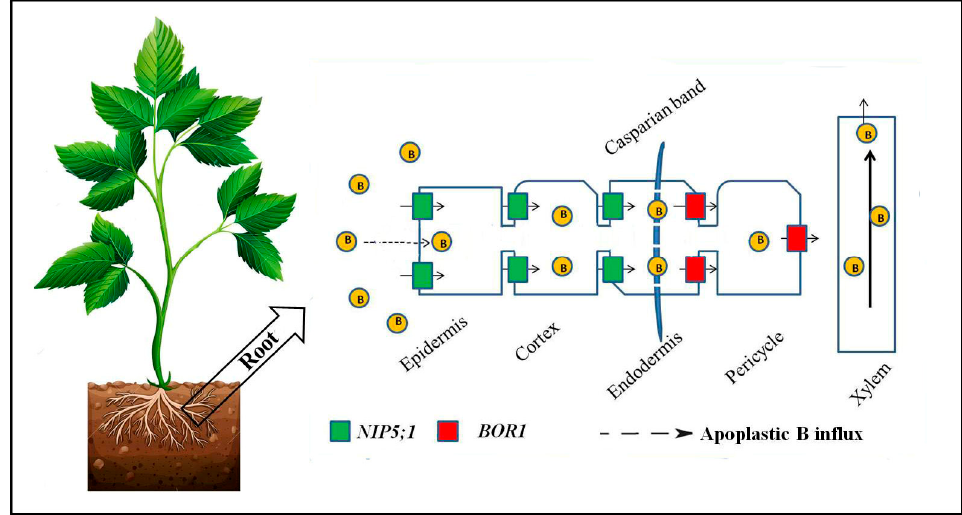
Figure 2. The mechanism of boron uptake and transport in plants under limited B conditions. Modified from Takano et al. [34].